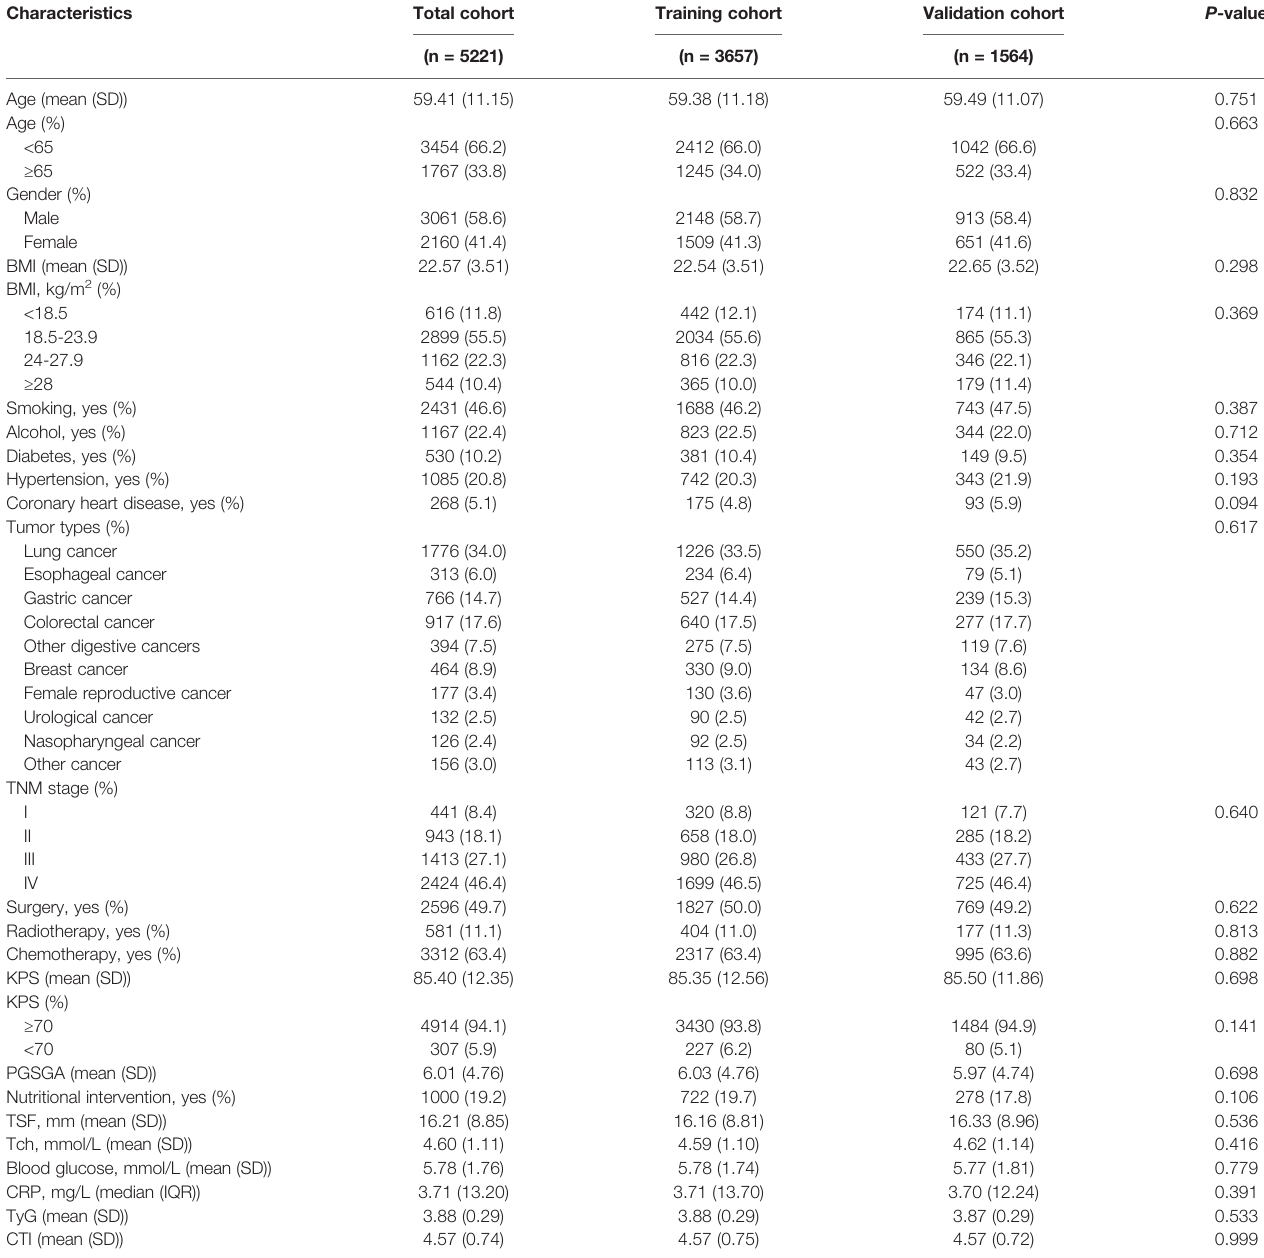
TABLE 1 | Baseline characteristics of the study